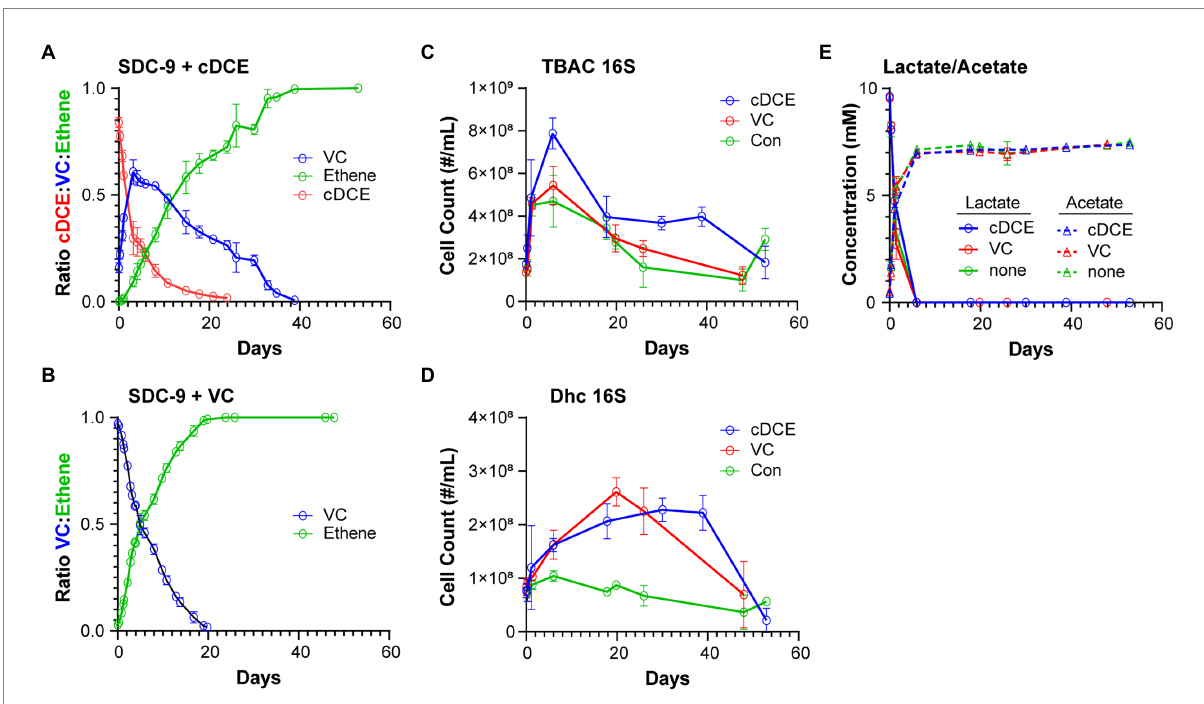
FIGURE 1 (Chloro)ethene, qPCR, and electron donor data illustrating the performance of SDC-9 ™ cultures utilizing cDCE or VC as an electron acceptor. (Chloro)ethene concentrations measured during dechlorination of (A) cDCE and (B) VC to ethene; 16S rRNA gene copy numbers for (C) total bacteria (TBAC) and (D) Dhc in cultures under different growth conditions; and (E) lactate consumption and acetate formation in all cultures. Error bars represent standard deviation of replicate